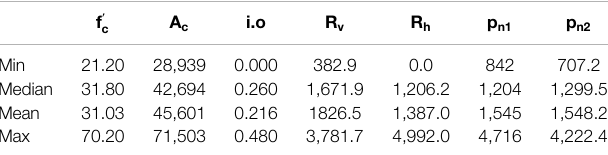
TABLE 4 | Summary of data used to develop the ANN